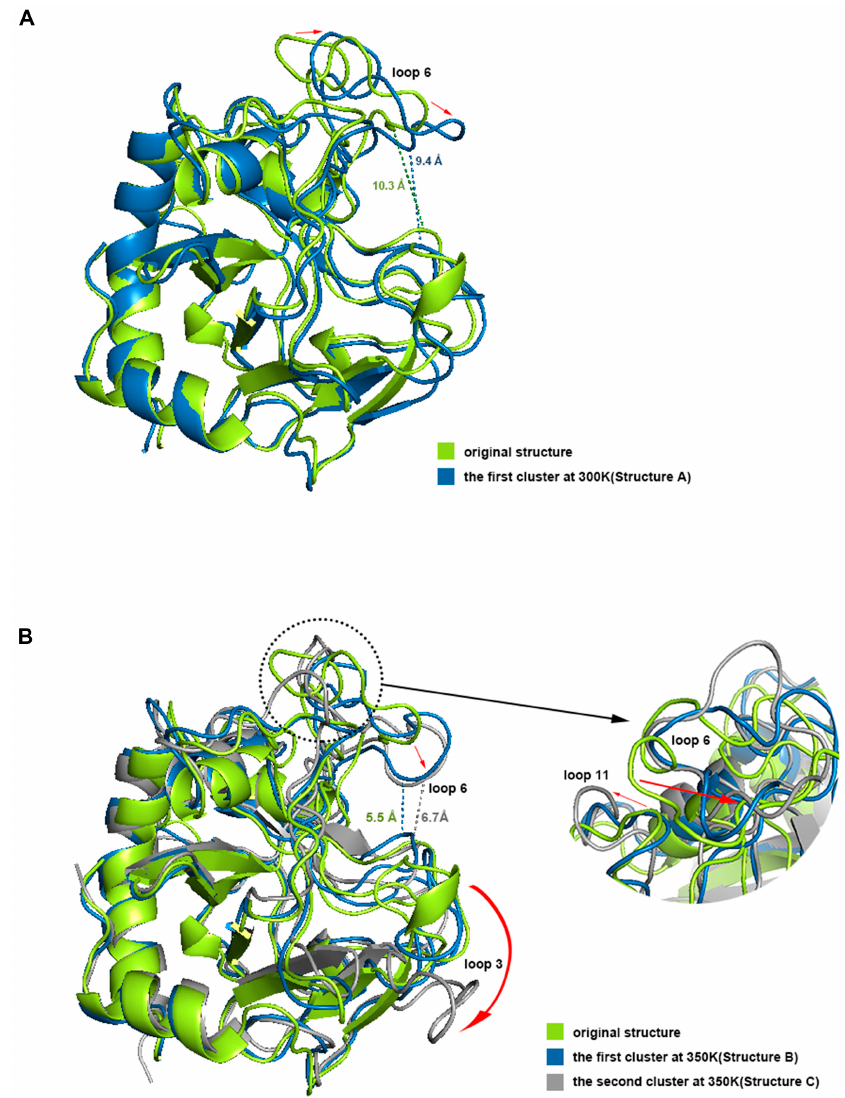
Figure 9. ( A , B ) shows the aligning of the dominant conformations with the initial structure at 300 K and 350 K respectively. The dotted lines represent the distance at the narrowest positions of the conformational openings and the red arrows represent the motion trends of residues.